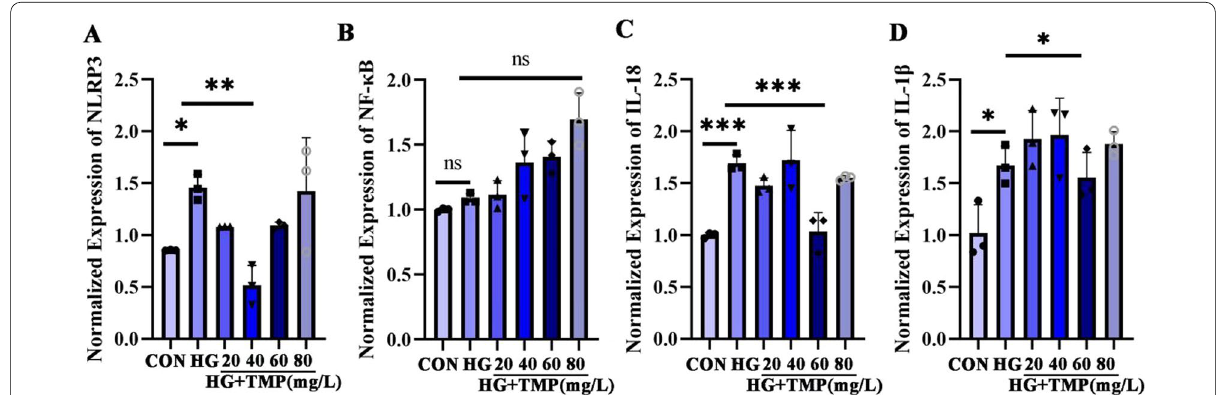
Fig. 5 A–D To evaluate the improvement effect of Chuanxiong active components on inflammatory factors at transcription level. * P < 0.05; ** P < 0.01; *** P <